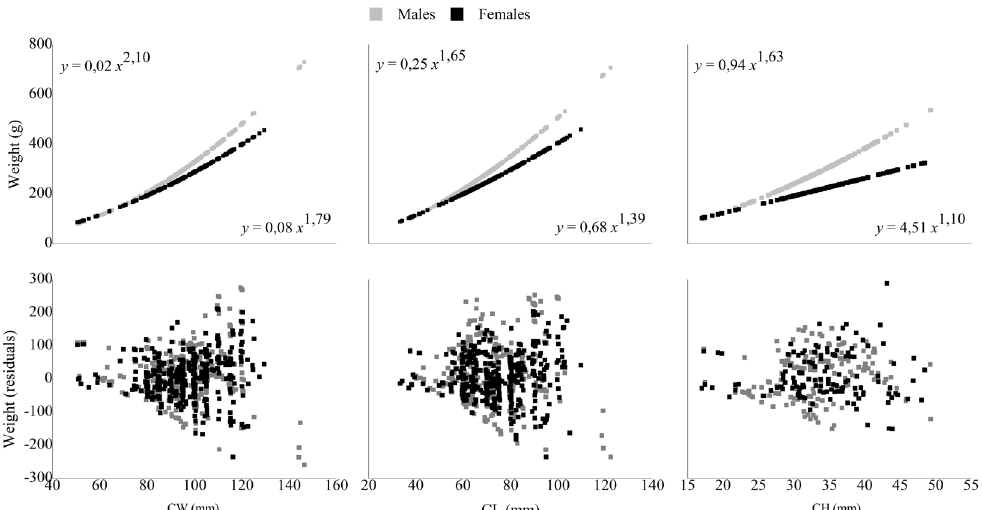
Figure 2. Weight-Size relationships of Menippe frontalis in Posorja, Gulf of Guayaquil, Ecuador, and residuals vs predicted values obtained from the power model. CW, carapace width; CL, Carapace length; CH, carapace height.